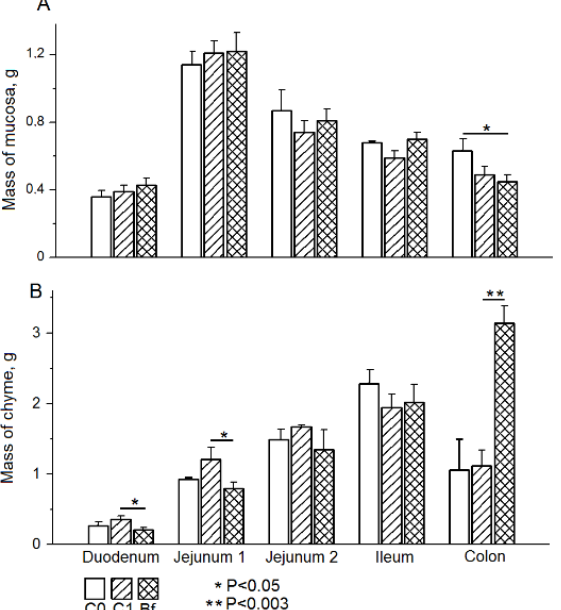
Figure 2. Influence of indigenous bifidobacteria on the mass of the mucosa ( A ) and chyme ( B ) in different parts of the intestine in a rat model of antibiotic-associated dysbiosis. ( A , B ) The rat groups: C0 (control)—without the introduction of antibiotics and autoprobiotics, C1—without the introduction of autoprobiotics after the withdrawal of antibiotics, and Bf—with the introduction of indigenous bifidobacteria after the withdrawal of antibiotics. ( A ) Student’s t -test, * p < 0.05. ( B ) Student’s t -test, * p < 0.05, ** p <